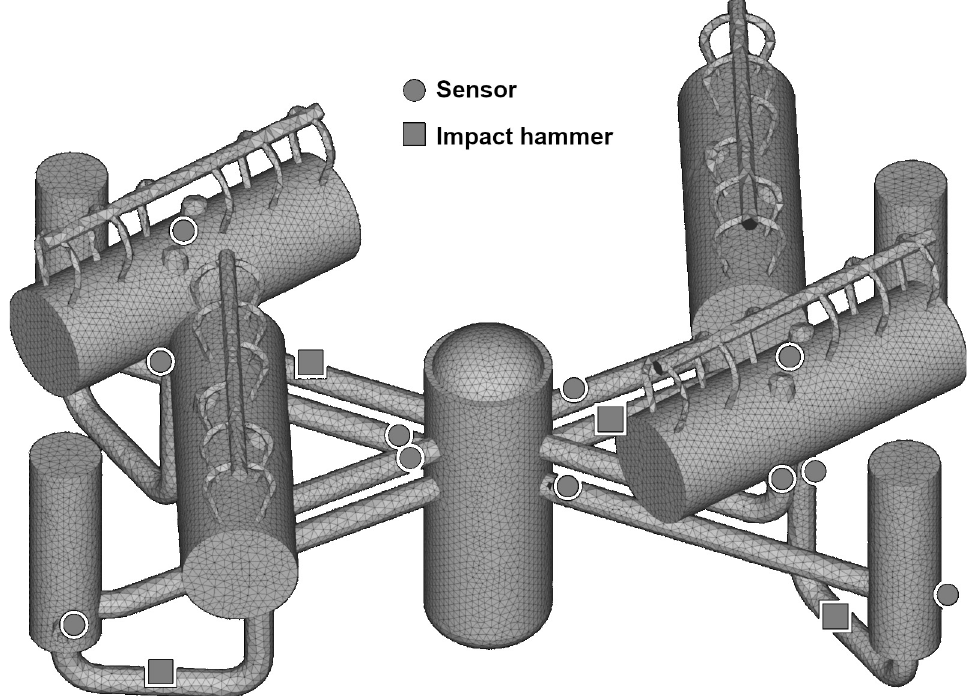
Figure 3. Geometric model of the RP surface and the location of the sensors and